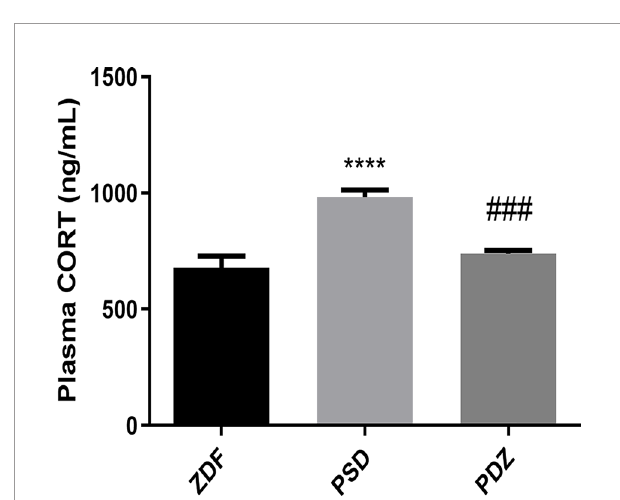
FIGURE 3 | Effect of ZBPYR on plasma corticosterone (CORT) levels. Bars represent the mean ± SEM of 6 rats per group. **** P < 0.0001, PSD group vs. ZDF group; ### P < 0.001, PDZ group vs. PSD